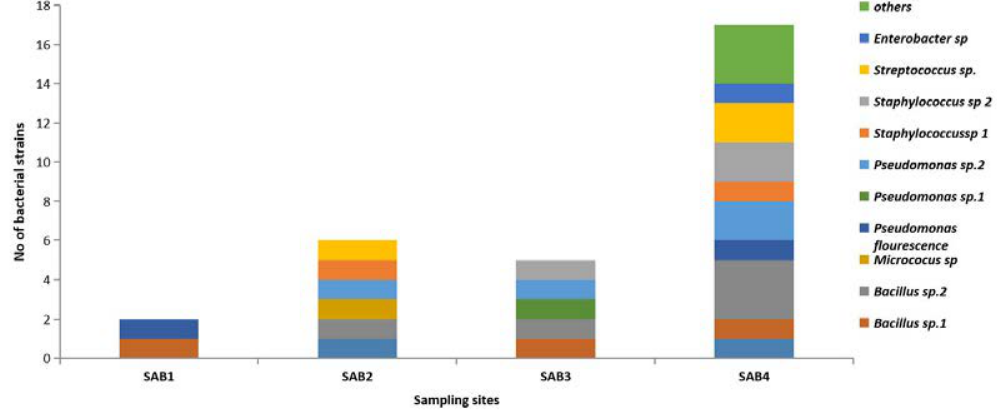
Fig. 2. Relative abundance of bacterial genera in different study Table 3. Percentage degradation of crude oil by four bacterial strains at different interval of time after incubation (Data mean of 3 replicates ± SE) Strains(culture ID)